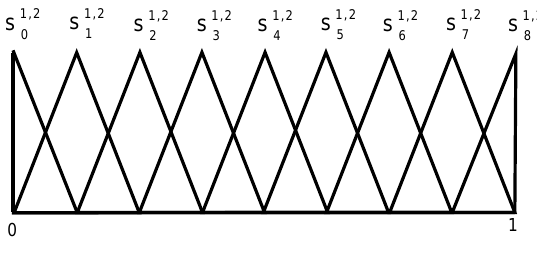
Fig. 5. The linguistic term set S 1 , 2